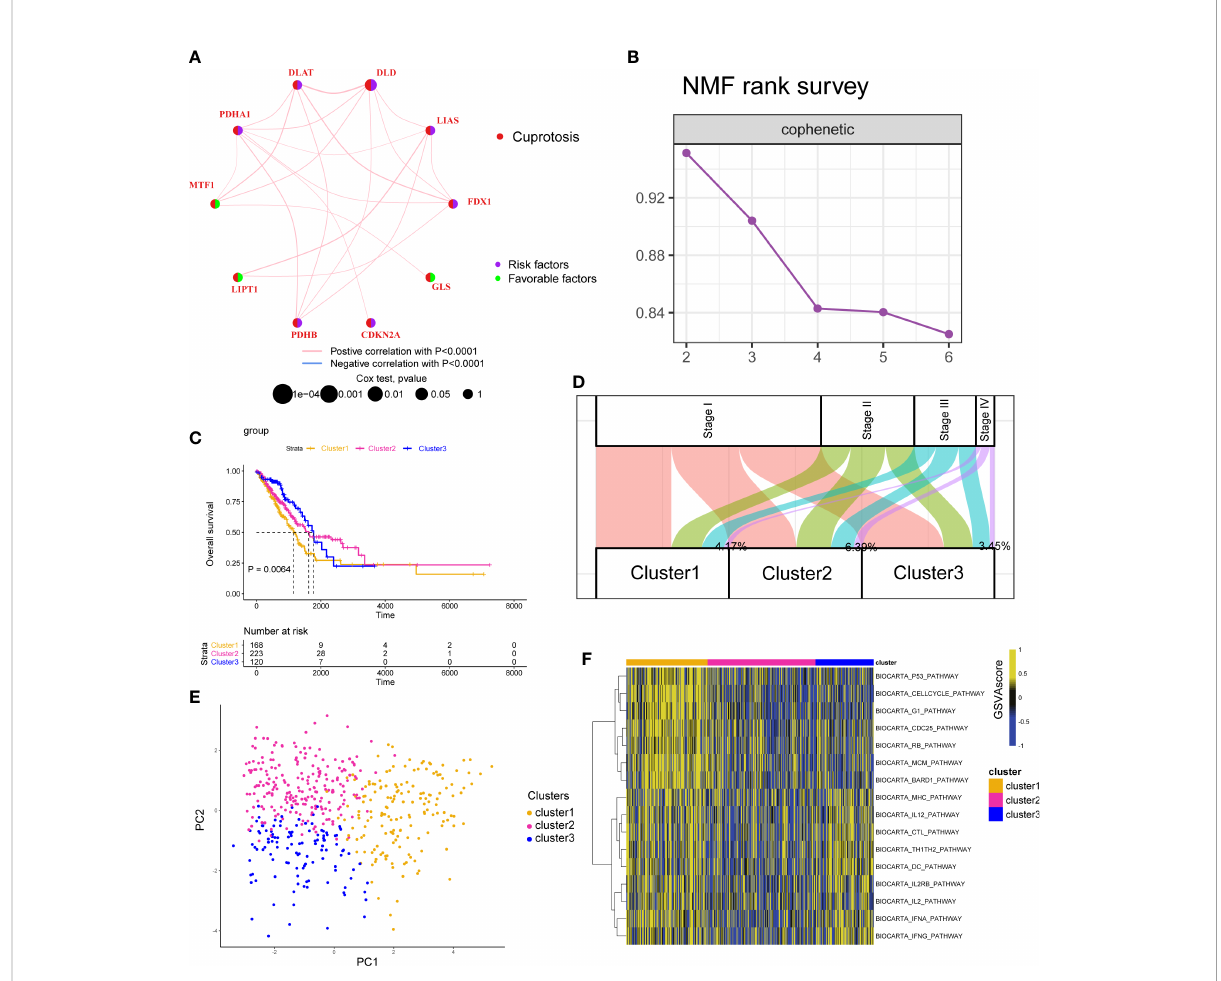
FIGURE 2 Cuproptosis-associated classi fi cations in lung adenocarcinoma. (A) A network describes the connection and prognostic values of 10 cuproptosis-associated genes. (B) The non-negative matrix factorization (NMF) rank survey was shown. The optimal number of clusters: rank = 3. (C) K – M survival plots according to NMF clusters. The P value was determined by the log-rank test. (D) The distribution plot shows the composition of clinicopathological features of three NMF clusters. (E) Principal component analysis shows the distribution of three NMF clusters. (F) Corresponding pathway activities of three NMF